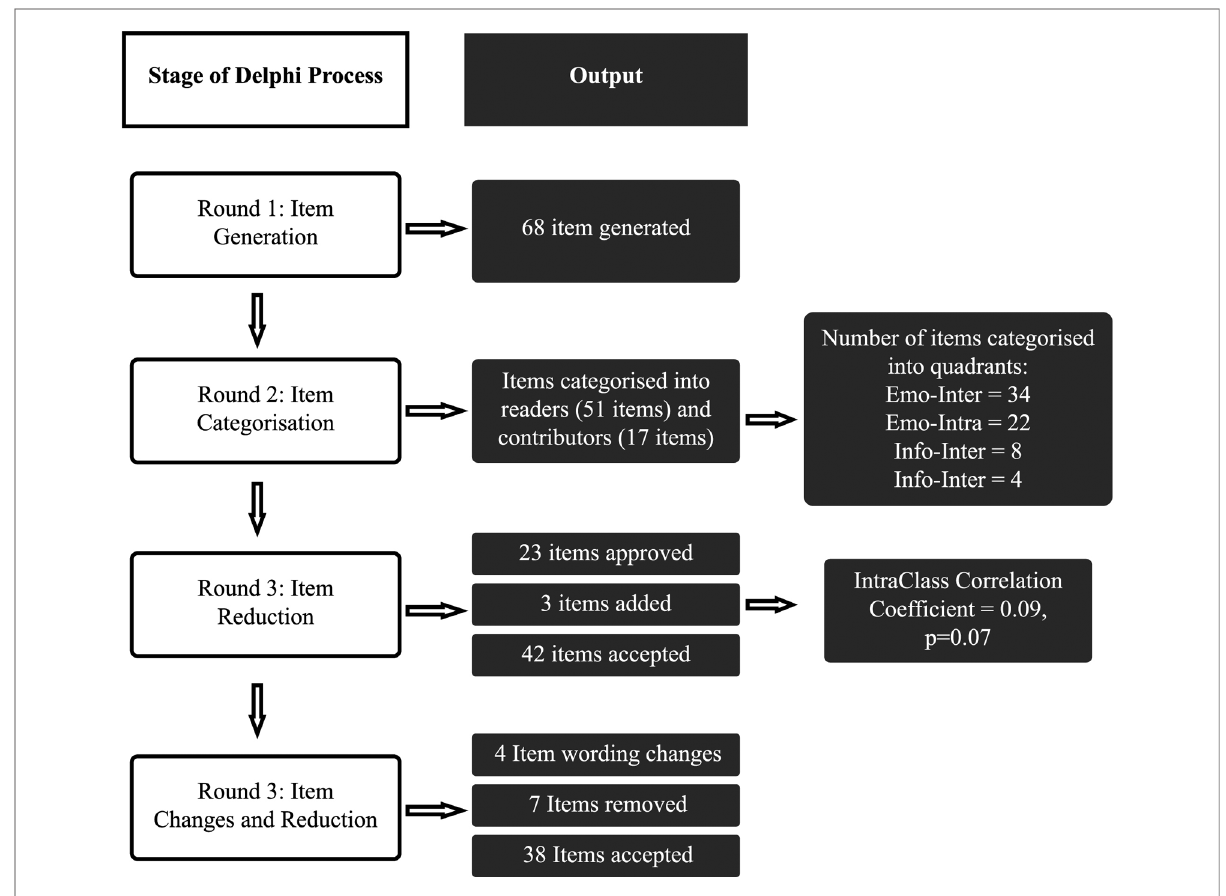
FIGURE 3 A fl ow chart of the results from each stage of the Delphi process for the generation and reduction of